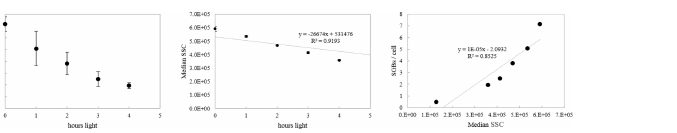
Fig 1. Correlation between SGBs per cell and FCM median SSC for anoxygenic PSB C . okenii . (A) Intracellular sulfur globules(SGBs) consumptionper cell in function of light hours irradiation.(B) Flow cytometry mediansidewardscatter (SSC) decreasein function of light hours irradiation. (C) Correlation betweennumberof SGBs per cell and medianSSC in PSB C . okenii .